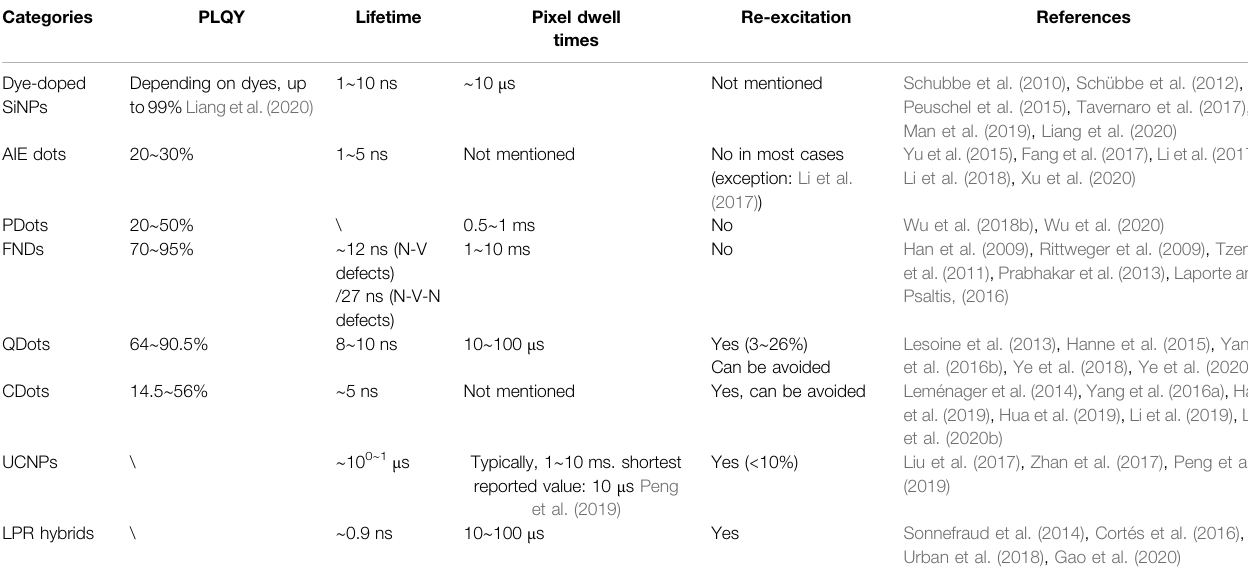
TABLE 3 | Summary of excitation/emission features for different STED